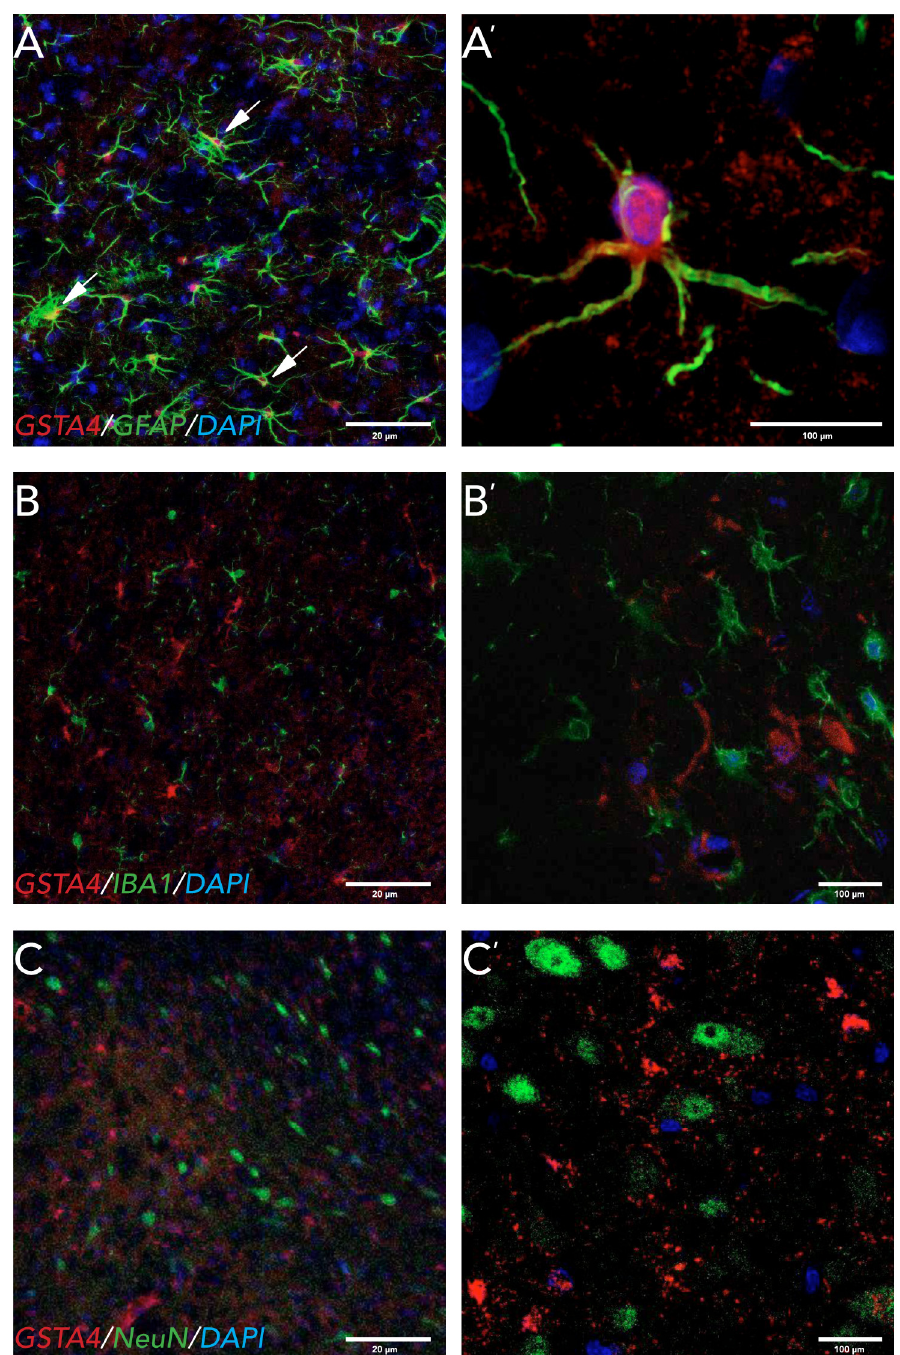
Figure 4. Expression of GSTA4 in midbrain astrocytes 8 weeks after striatal 6-OHDA lesion. Figure 4 . Expression of GSTA4 in midbrain astrocytes 8 weeks after striatal 6 ‐ OHDA lesion. Immunofluorescent Immunofluorescent staining of GSTA4 combined with cell-specific markers for ( A ) astrocytes; GFAP, staining of GSTA4 combined with cell ‐ specific markers for ( A ) astrocytes; GFAP, ( B ) microglia; IBA1 and ( C ) ( B ) microglia; IBA1 and ( C ) neurons; NeuN. GSTA4 staining co-localized with GFAP ( A’ ) but not IBA1 neurons; NeuN. GSTA4 staining co ‐ localized with GFAP ( A’ ) but not IBA1 ( B’ ) or NeuN ( C’ ), suggesting ( B’ ) or NeuN ( C’ ), suggesting astrocytic expression. ( A – C ) Pictures taken at 20 × ; scale bar = 20 µ m. astrocytic expression. ( A – C ) Pictures taken at 20×; scale bar = 20 μ m. ( A’ ) Zoomed in 60× image showing ( A’ ) Zoomed in 60 × image showing co-localization, with GSTA4 mainly expressed in the soma. Scale co ‐ localization, with GSTA4 mainly expressed in the soma. Scale bar = 100 μ m. ( B’ , C’ ) Pictures taken at 60×, bar = 100 µ m. ( B’ , C’ ) Pictures taken at 60 × , scale bar = 100 µ m. All markers were combined with scale bar = 100 μ m. All markers were combined with nuclear marker DAPI (blue). nuclear marker DAPI